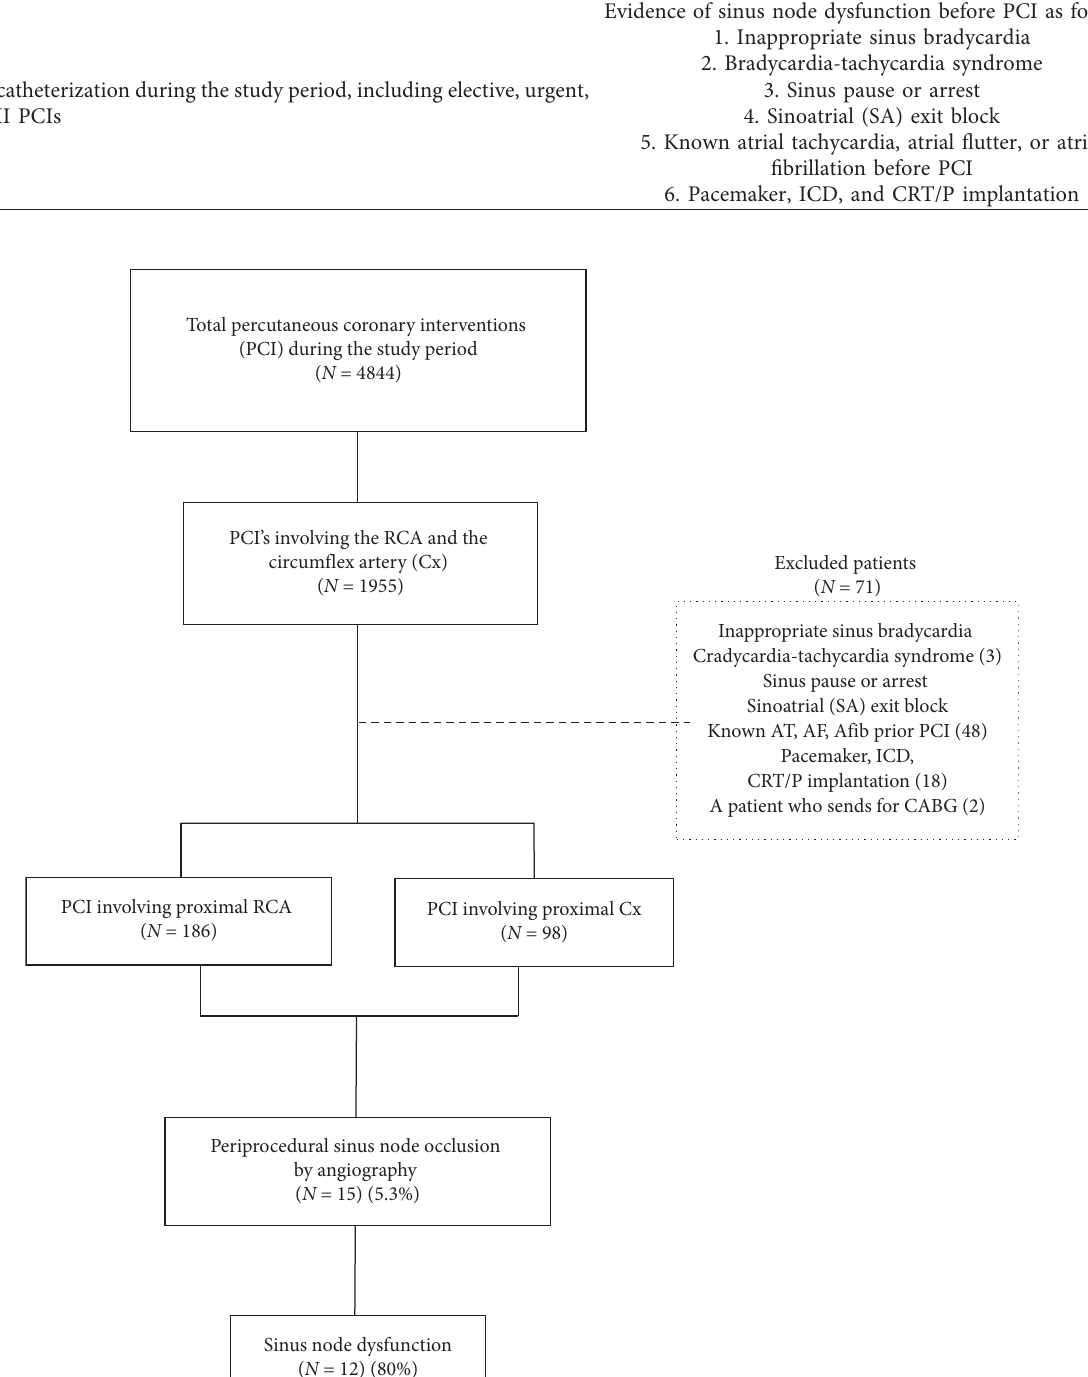
Table 1: Inclusion and exclusion criteria. Inclusion criteria Exclusion criteria